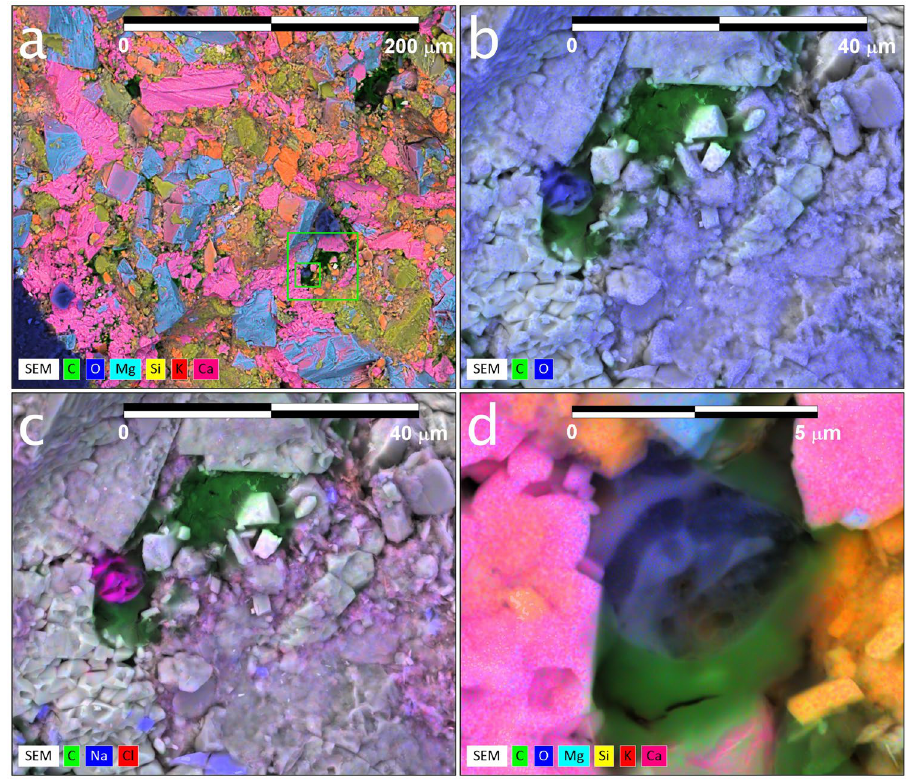
Figure 6. ( a ) Elemental map (300 µ m × 300 µ m) superimposed on a back-scatter electron image of the cryogenically-frozen Bakken sample after it was first submersed in formation oil, then in synthetic brine. ( b ) Zoom in of larger green square in ( a ) illustrating elemental map of carbon and oxygen only, and location of oil (green) and synthetic brine (blue) in intergranular space. ( c ) Same image as ( b ), but with the elements of sodium and chloride added instead of oxygen to demonstrate that the identified water in the intergranular space is synthetic brine. ( d ) Zoom in of smaller green square in ( a ) to illustrate the distribution of oil (green) and synthetic brine (blue) in the intergranular